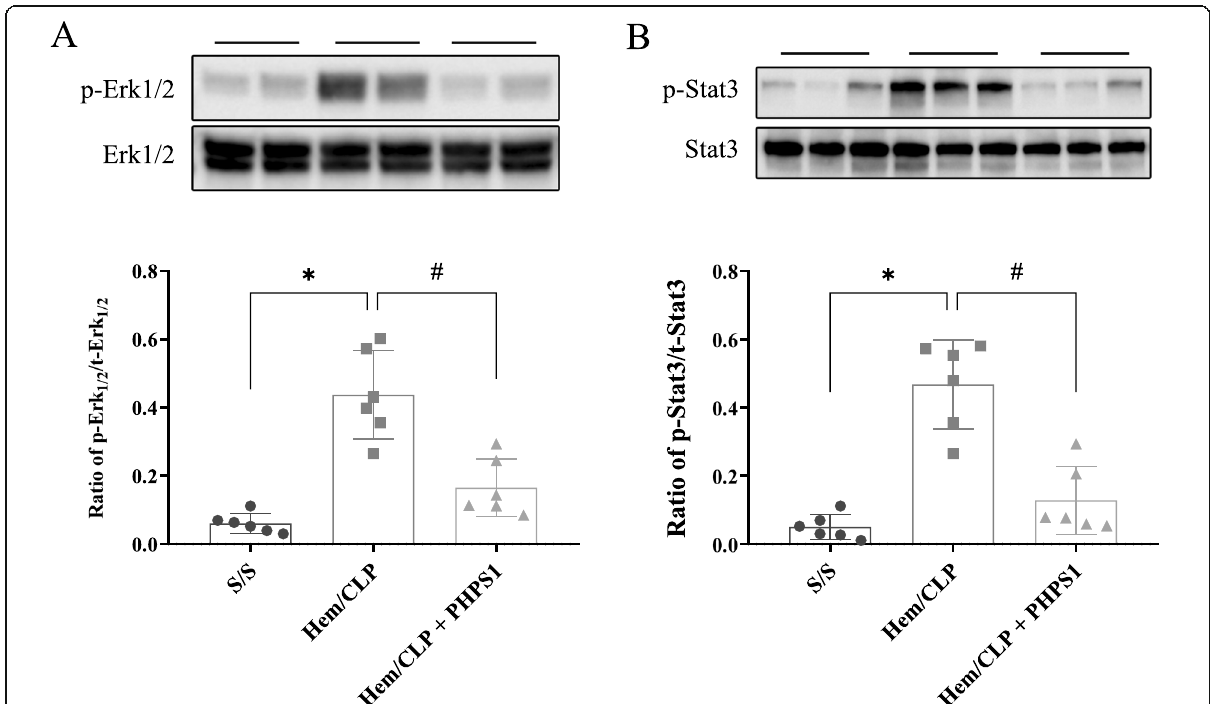
Fig. 7 Effects of PHPS1 on expression of activation of Erk1/2 and STAT3 in kidney after Hem/CLP. Twenty four h post Hem/CLP or sham operation, the kidneys were collected and tissue homogenates were obtained. The extent of Erk1/2 ( a ) and STAT3 ( b ) activation (phosphorylation) was determined by western blot. The ratio of phosphorylated Erk1/2 and total Erk1/2 (p-Erk1/2/t-Erk1/2) and phosphorylated STAT-3 and total STAT-3 (p-STAT-3 /t- STAT-3) in kidneys from Hem/CLP mice was significantly increased compared to Shams. PHPS1 treated Hem/CLP mice showed reduced Erk1/2 and STAT3 activation compared to Veh treated HEM/CLP mice. *, P <0.05, versus sham (S/S); #, P <0.05, PHPS1 treated group (Hem/CLP+PHPS1) versus Hem/CLP+vehicle (Hem/CLP). One-way ANOVA and a Student-Newman-Keuls ’ test, Mean±SD; n =6